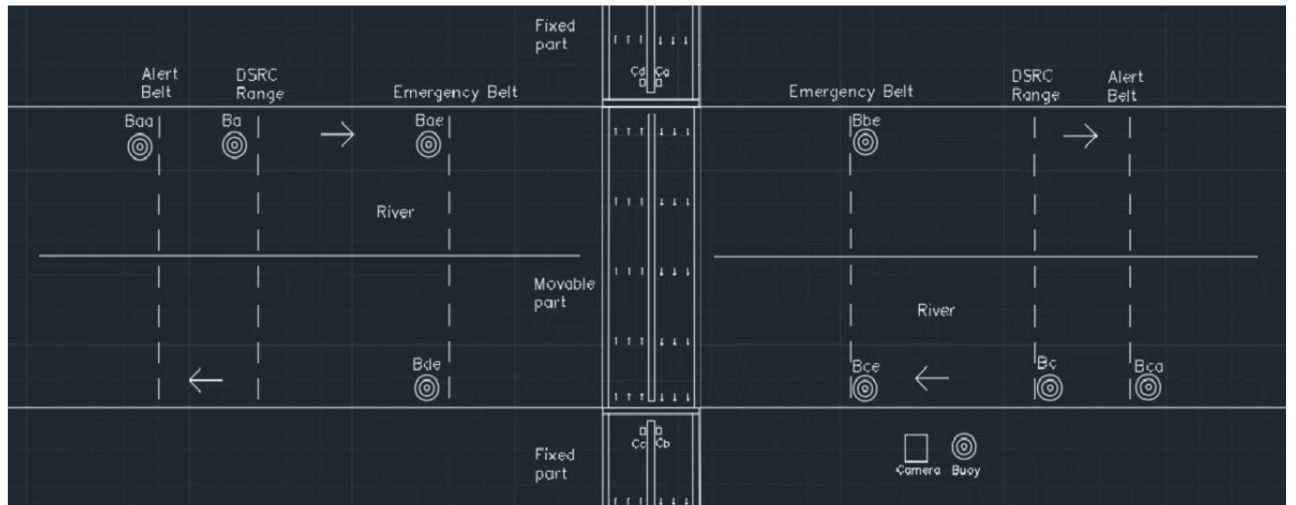
Figure 3. Illustration of the complete system and installments with specific legends. For design consideration, four fixed buoys are installed at each of the two ship routes. according to the following